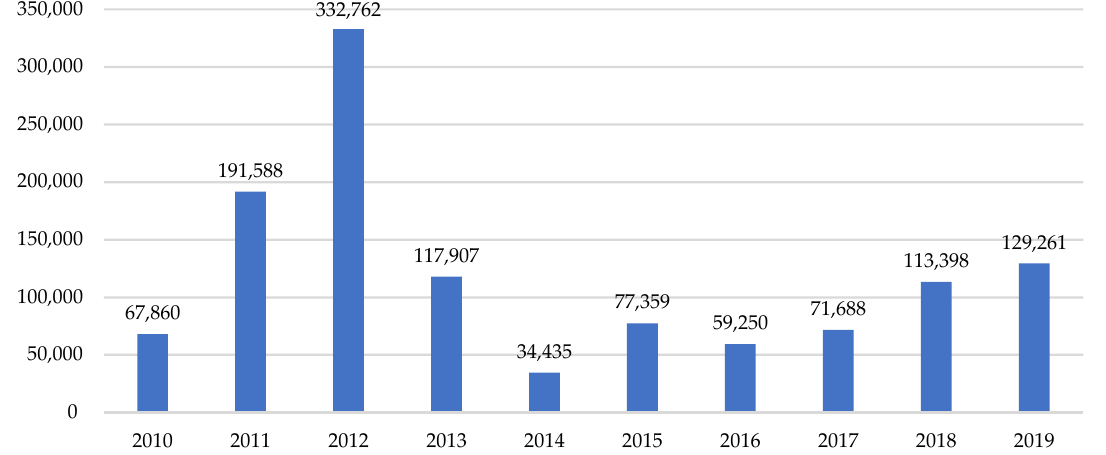
Figure 3. Cargo volumes of biomass in the port of Szczecin in 2010–2020 (tons).